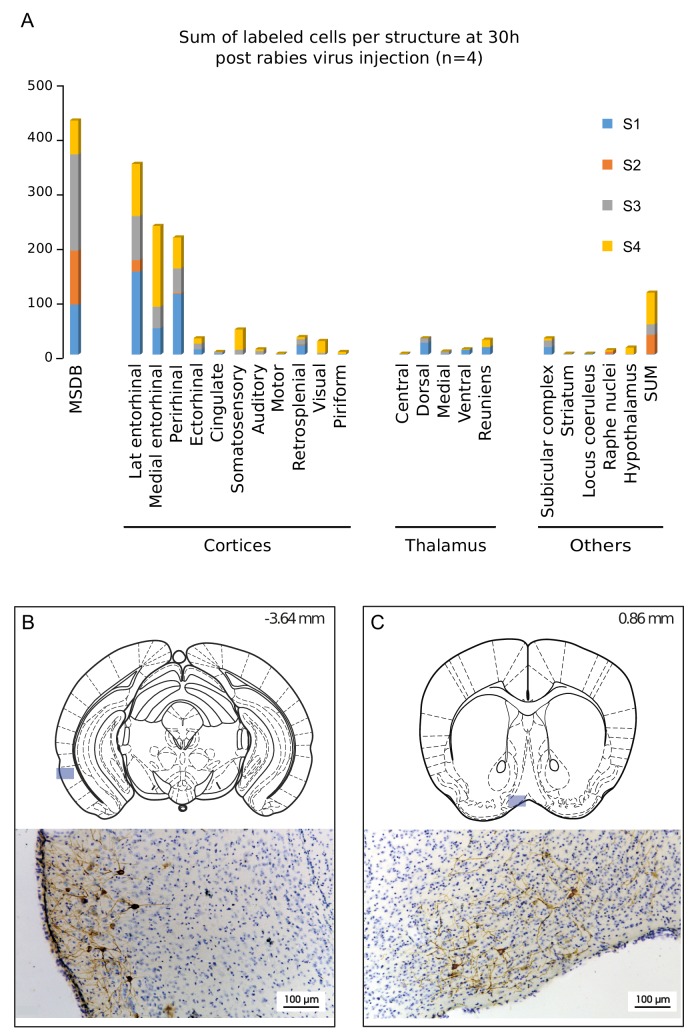
Structures labeled 30 hr after hippocampal rabies injection.(A) Cumulative sum of labeled cells per structure 30 hr post-hippocampal rabies injection (color coded for each case, n = 4 mice). B-C, Localization and representative photomicrographs of RABV in the two main labeled regions at 30 hr, the lateral entorhinal cortex (B) and the MSDB (C). The position is indicated by a blue insert on a standard coronal outline of a brain section, and rostro-caudal position according to Bregma is indicated in the top-right corner. Abbreviations, Lat entorhinal cortex, lateral entorhinal cortex; MSDB, medial septum/diagonal band of Broca; SUM, supramammillary nucleus.